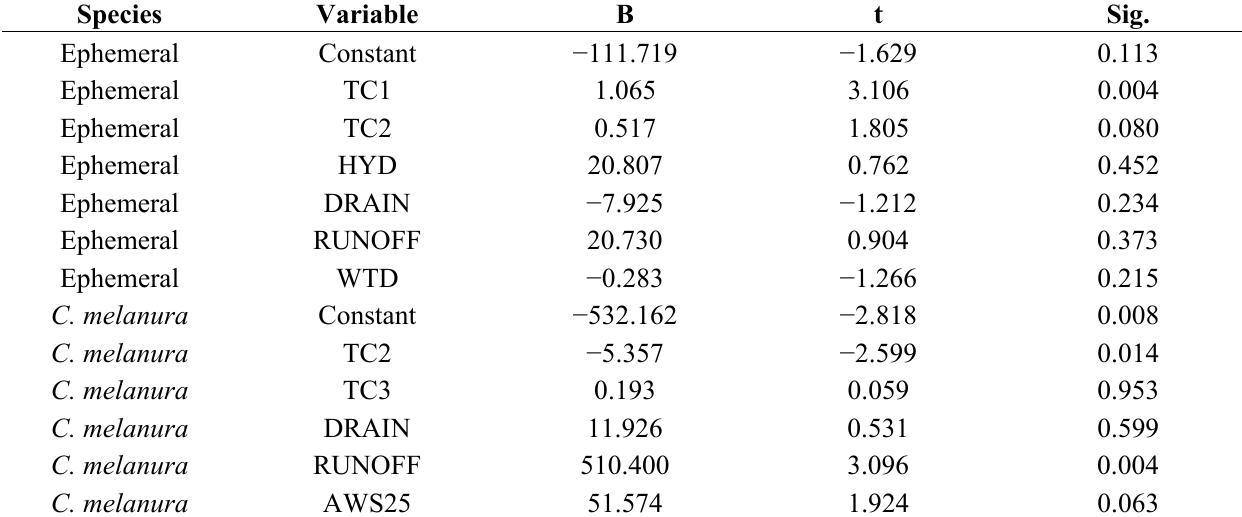
Table 3. Results of the HSI linear regression